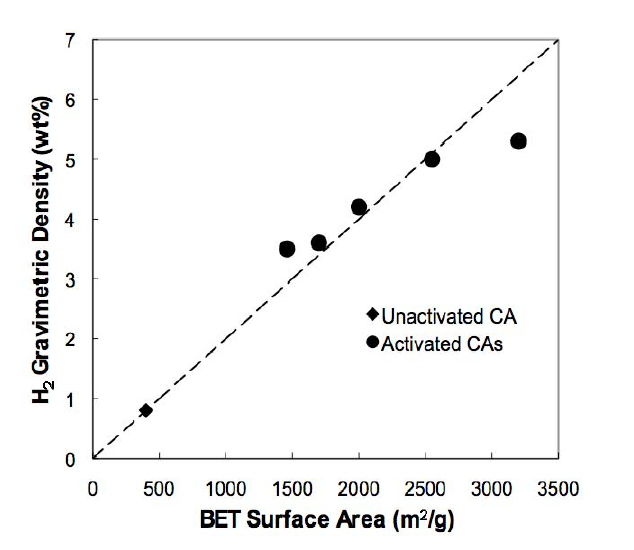
Figure 10. Excess gravimetric density (wt % H BET surface area. The dotted line shows correlation of 1 wt % per 500 m 2